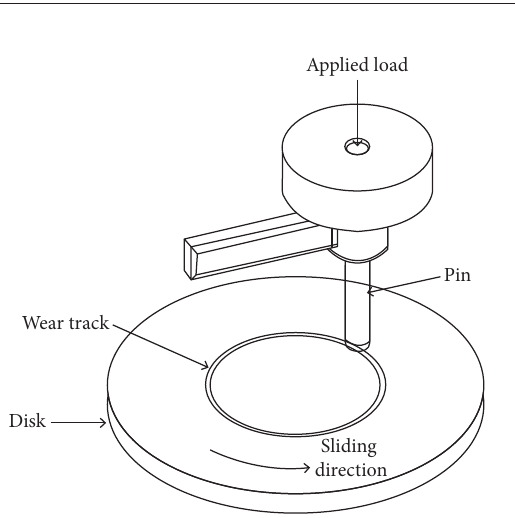
Figure 1: Schematic representation of a ball-on-disk test of the tribo-pair of AISI 1538MV steel disk and WC